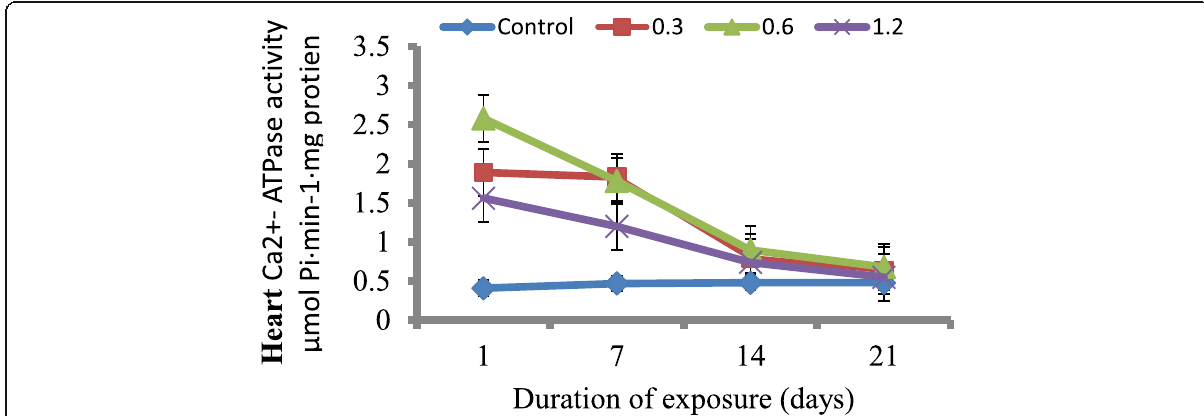
Fig. 4 Changes in the heart Ca 2+ -ATPase activity in Clarias gariepinus juvenile exposed to oxadiazon (mean ± SD)